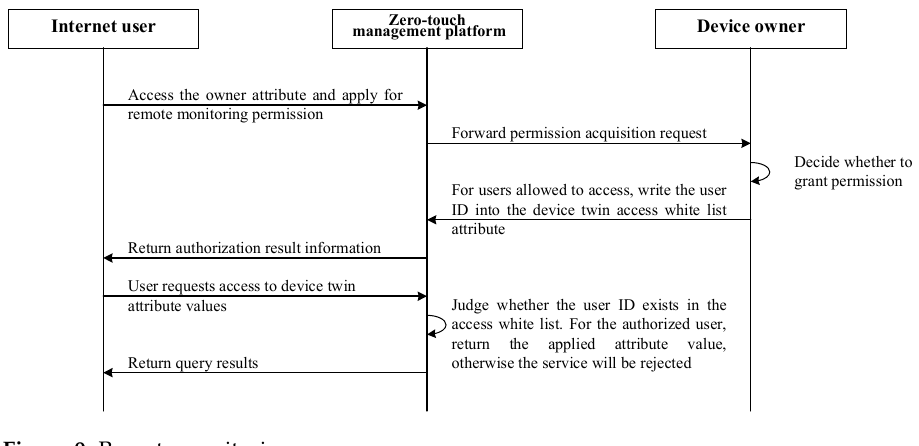
Figure 9. Remote monitoring